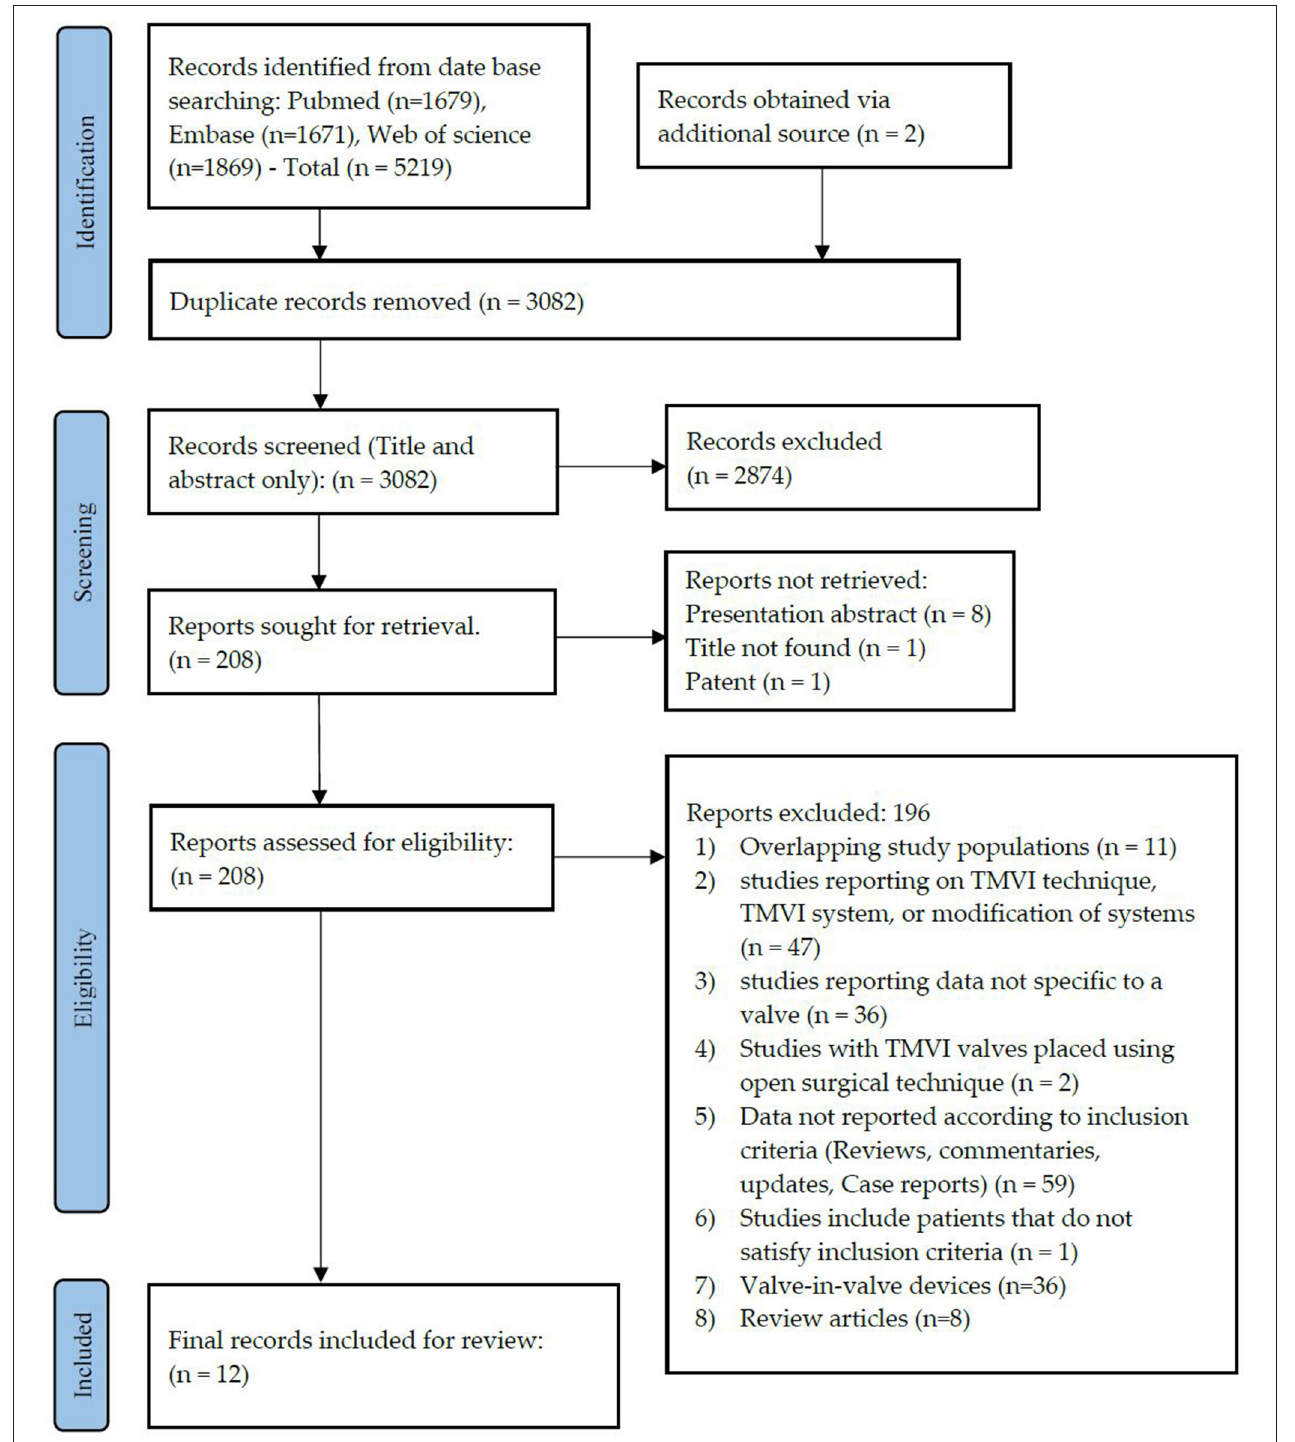
FIGURE 2 | PRISMA flow diagram. PRISMA chart illustrating our process of obtaining the 12 included articles. With 2,874 irrelevant records excluded based on their titles and abstracts, we reviewed the full texts of 208 articles, of which 196 were excluded, and 28 remained for inclusion in our study, of which 12 articles were included for final